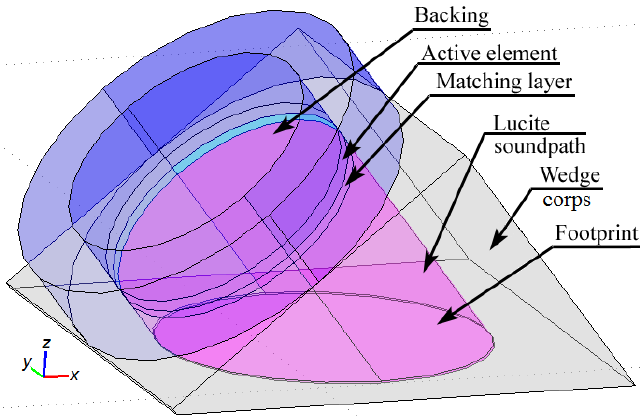
Figure 2. Geometry of the finite-element prototype for the used wedge transducer.